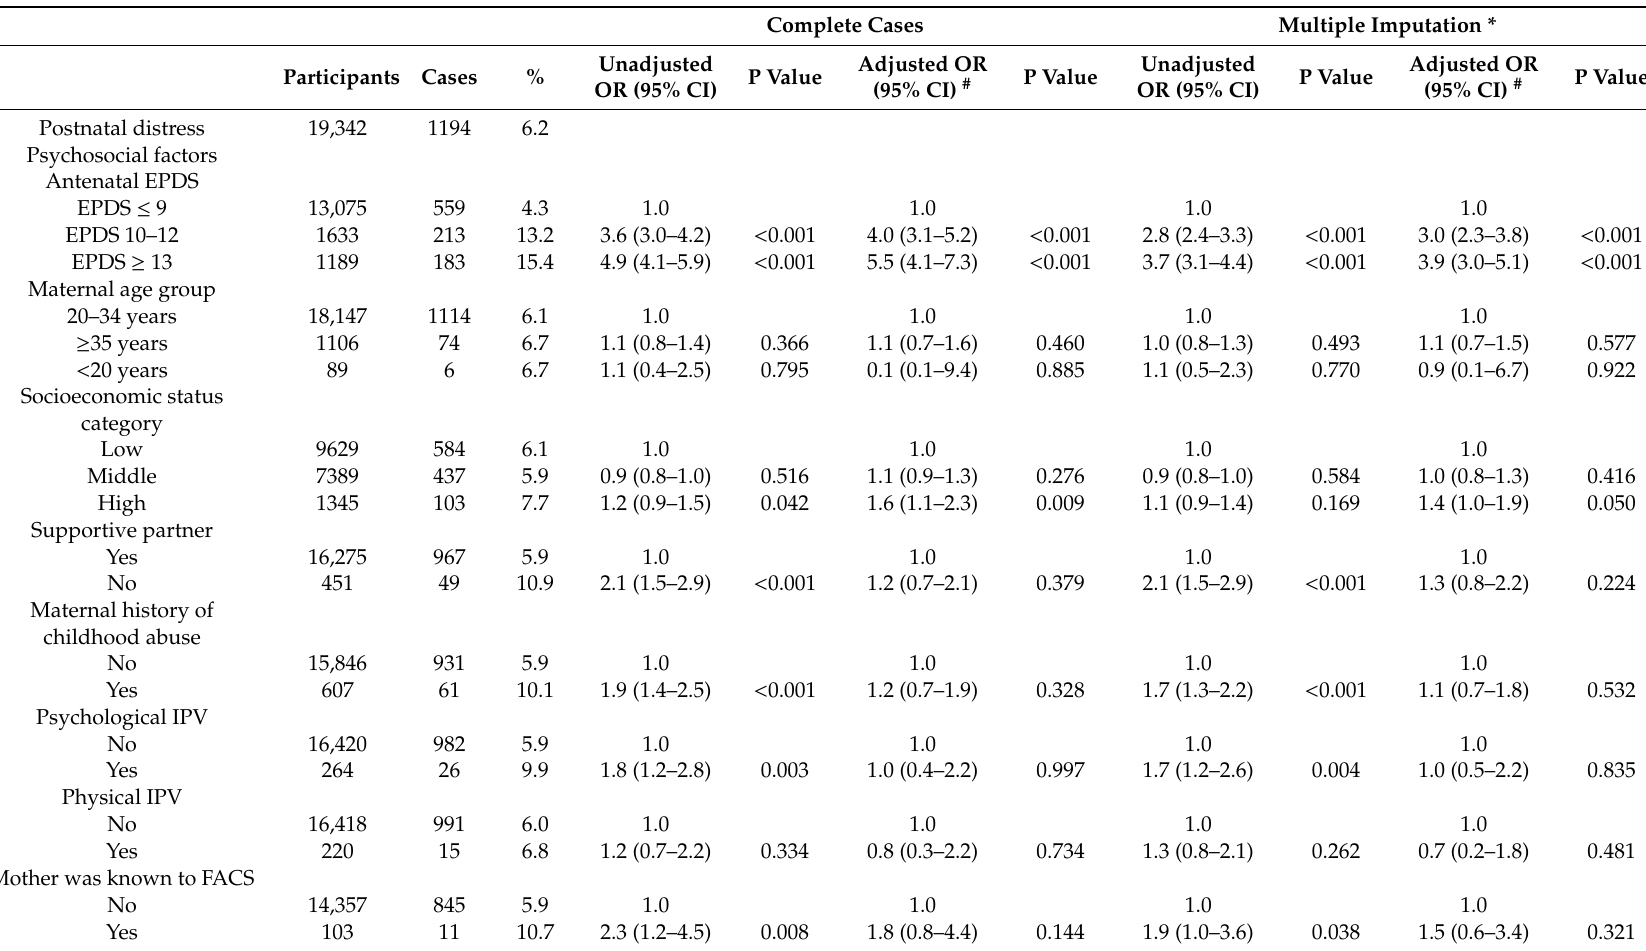
Table 3. Associations between the study factors and postnatal distress (EPDS = 10–12) in South Western Sydney and Sydney Local Health Districts,